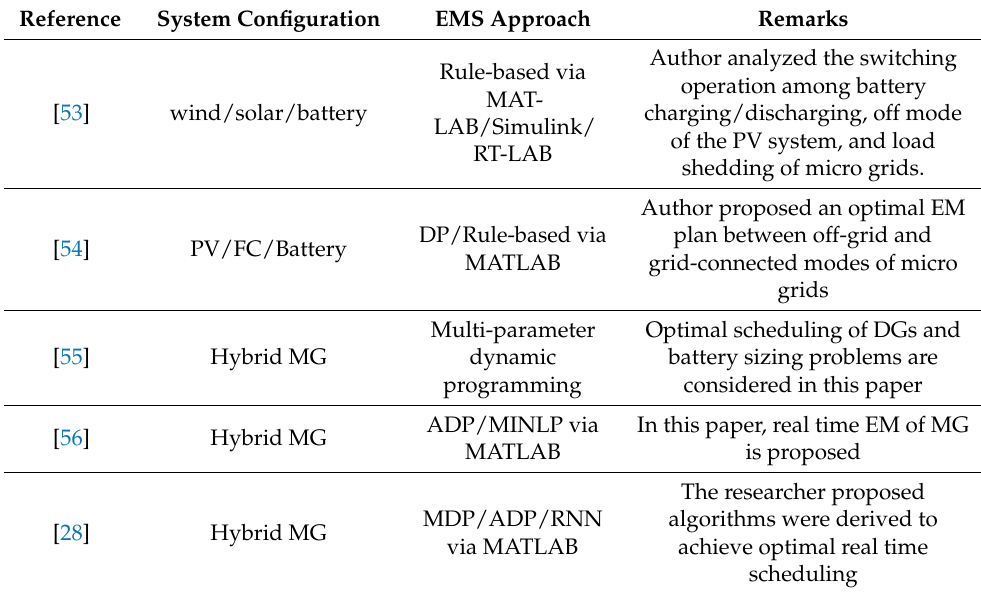
Table 2. Summary of recent studies of EMS based on rule/dynamic